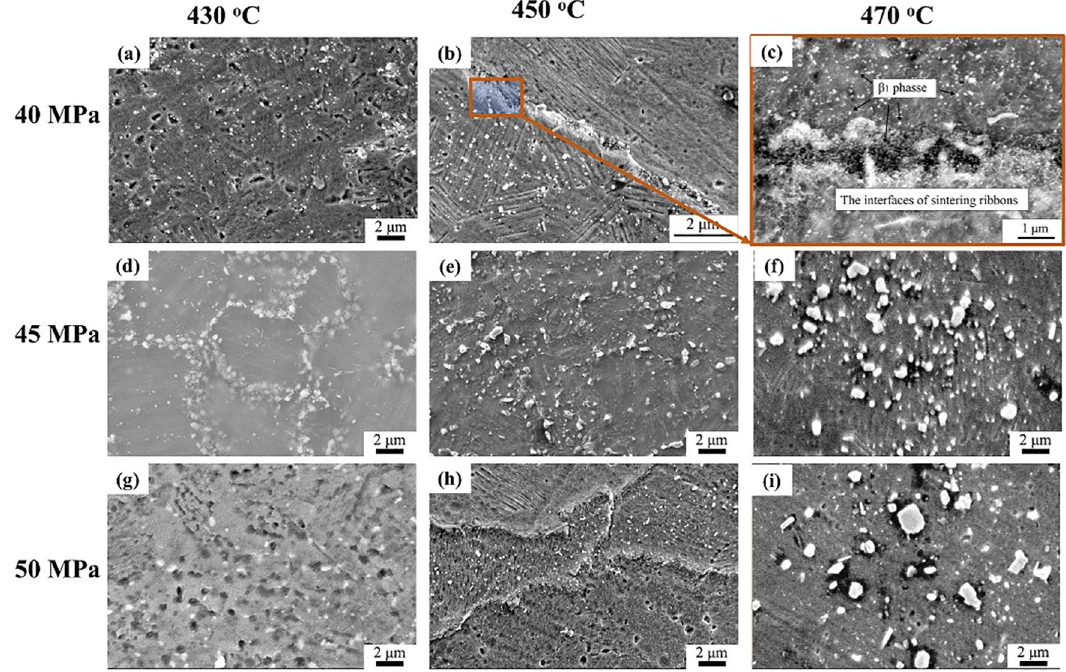
Figure 4. SEM images of sintered Mg-15Gd-1Zn alloy at various sintering pressures (40–50 MPa) and temperatures (430–470 °C): ( a , b) , and ( c) for 40 MPa; ( d–f) for 45 MPa; ( g–i) for 50 MPa, each time of sintered bulk was 5